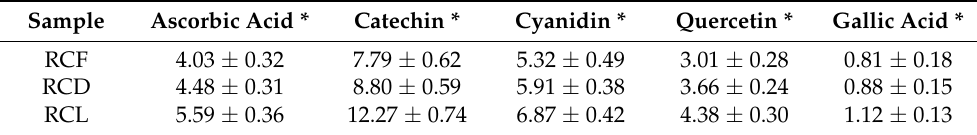
Table 1. Content of ascorbic acid and phenolic compounds from the extract of RCF, RCD, and RCL. Sample Ascorbic Acid